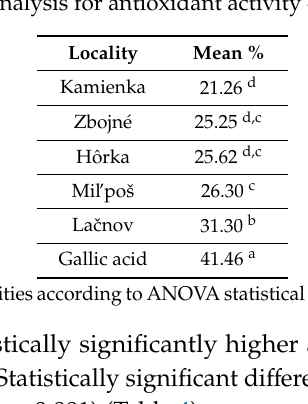
Table 3. Multiple range analysis for antioxidant activity of NCB extracts by locality.